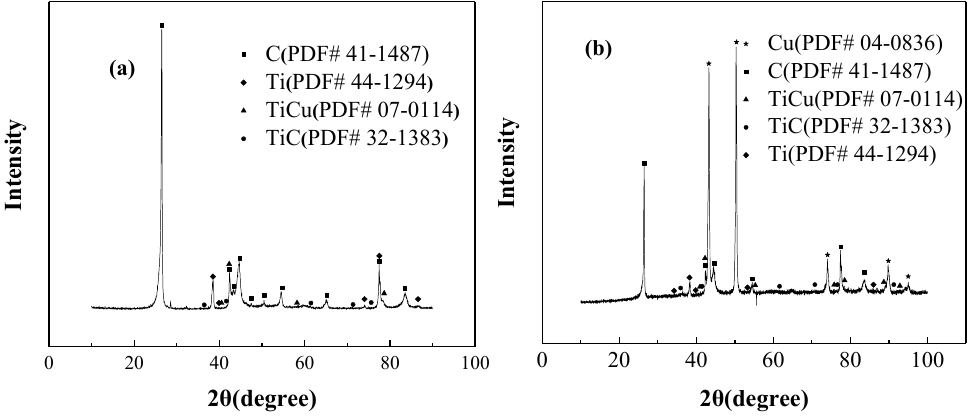
Figure 12. XRD results of the fracture surface of the welded joints: ( a ) C/C side, ( b ) Cu side.